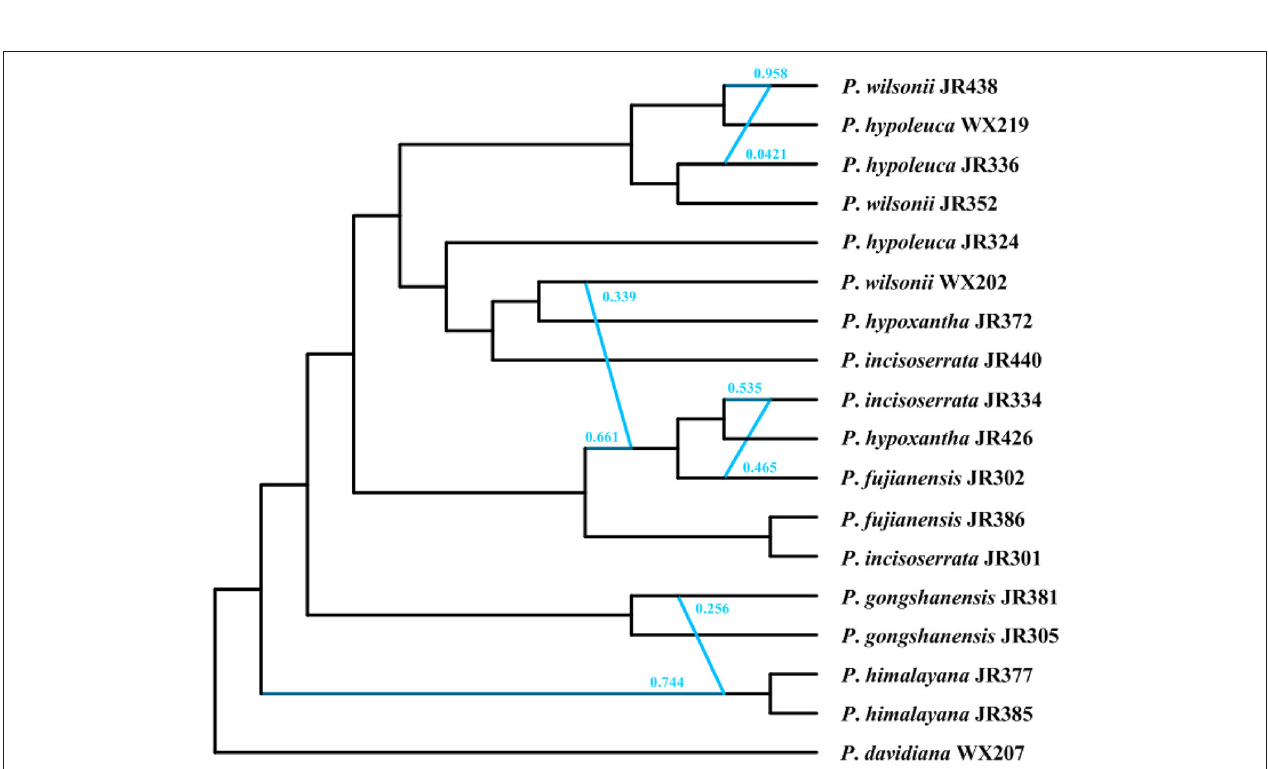
FIGURE 10 | The phylogenetic network inferred in the SNaQ/PhyloNetworks analysis. The blue line indicated the hybridization events in the network.